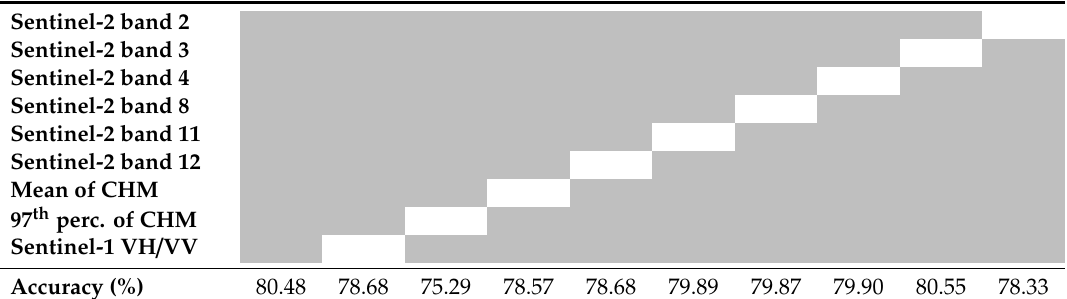
Table 2. Five-fold cross-validation accuracy (100 repeats) of predicted forest physiognomic types from support vector machine classification by leaving out one from the best combination of bands, that is from (i) Sentinel-2 spectral bands (2,3,4,8,11,12), (ii) mean and 97th percentile of canopy height model, and (iii) Sentinel-1 VH / VV bands. Grey shade shows which bands were